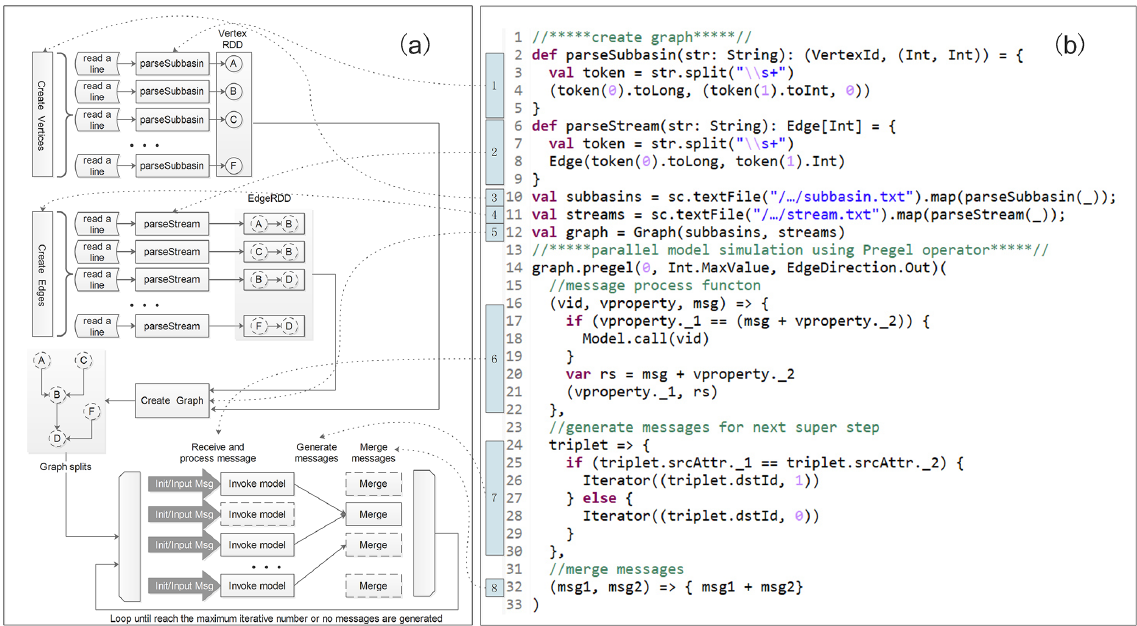
Figure 3. Schematic diagram of model parallelization with the Pregel algorithm (a) and code snippet of the driver program (b) (note that imported packages and some signatures have been removed for simplicity).